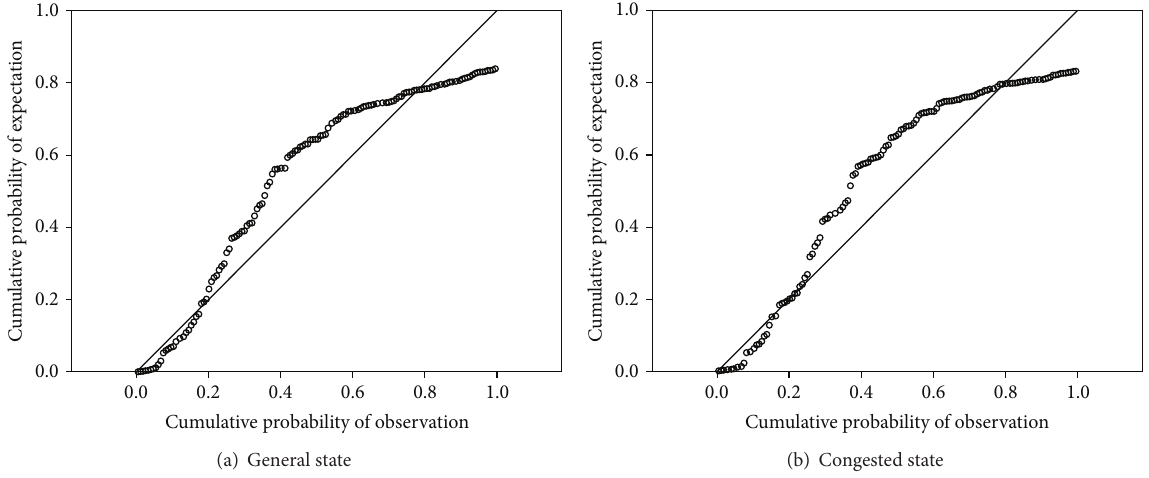
Figure 10: P-P figure of log-normal distribution fitting.